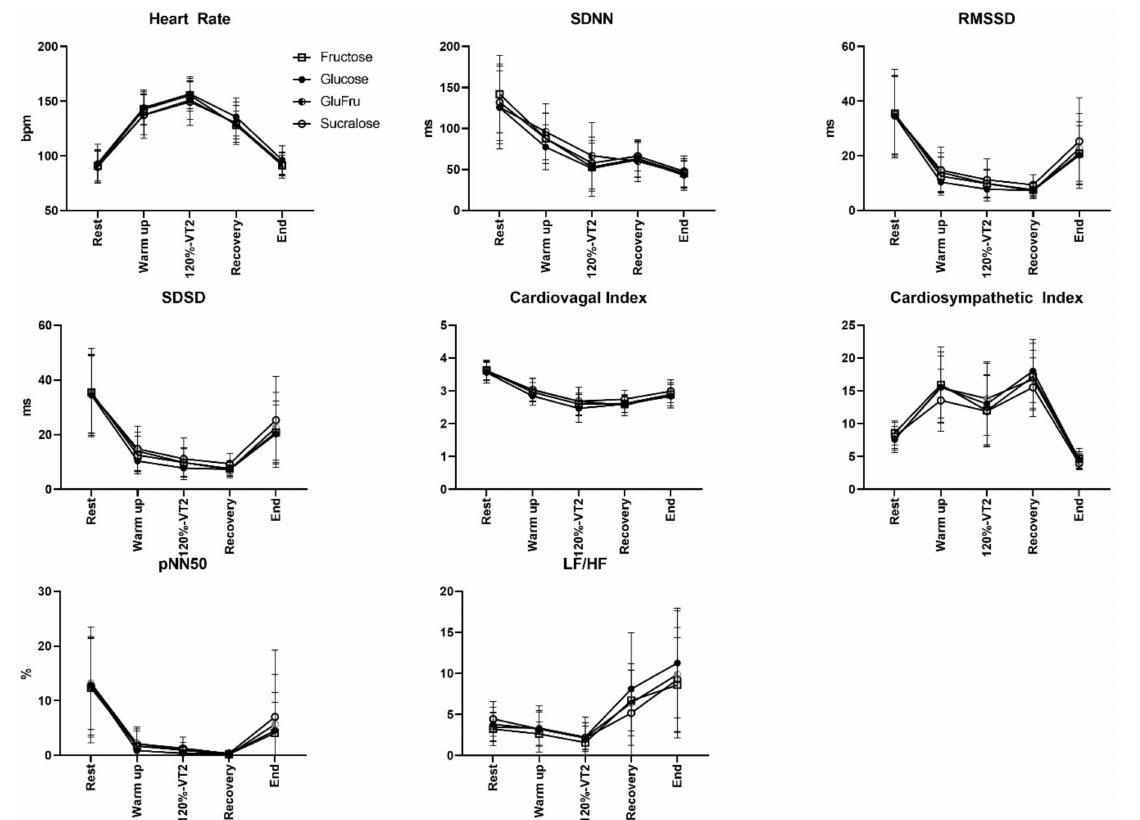
Figure 2. HRV variables during exercise test at rest, minute 1 of the warm-up, minute 1 of the exercise at 120% of the VT 2 (4 min), during recovery directly after the end of exercise, and 30 min after the end of the exercise. Open squares indicate fructose (Fru), full circles indicate glucose (Glu), half-circles indicate GluFru, and open circles indicate sucralose. SDNN: standard deviation of adjacent NN intervals; RMSSD: root mean square of adjacent NN intervals; QTc: corrected QT time; SDSD: related standard deviation of successive RR interval differences; pNN50: percentage of NN pairs that deviate by more than 50 ms; LF/HF: ratio between low frequency and high frequency.